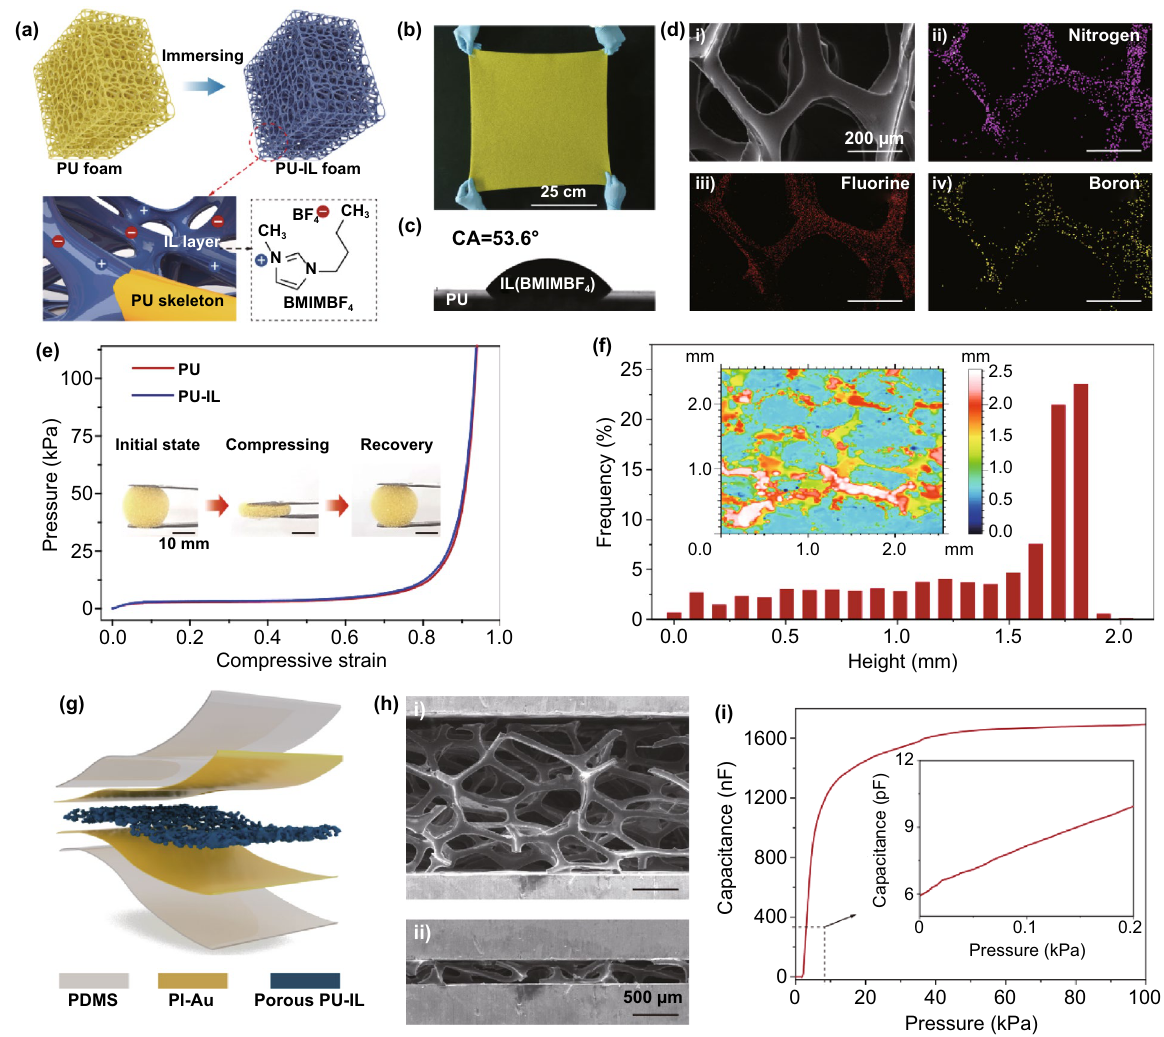
Fig. 3 PU-IL composite foam, flexible capacitive-type pressure sensor and its sensing property. a Schematic of a PU-IL composite foam with IL on the surface of PU skeleton. b A PU-IL composite foam with a dimension of 50 cm × 50 cm × 2 mm. c Contact angle of IL on the surface of PU plate. d Elemental mapping of nitrogen, fluorine and boron of the PU-IL composite foam. e Stress–strain curves of PU and PU-IL composite foams under compression. f Height distribution of the PU-IL composite foam. g Schematic of a capacitive-type pressure sensor that consists of two PI-Au electrodes, a PU-IL composite foam and a PDMS sealing layer. h SEM images of the PU-IL foam before and after compression. i Capacitance as a function of pressure of the sensor using our PU-IL composite